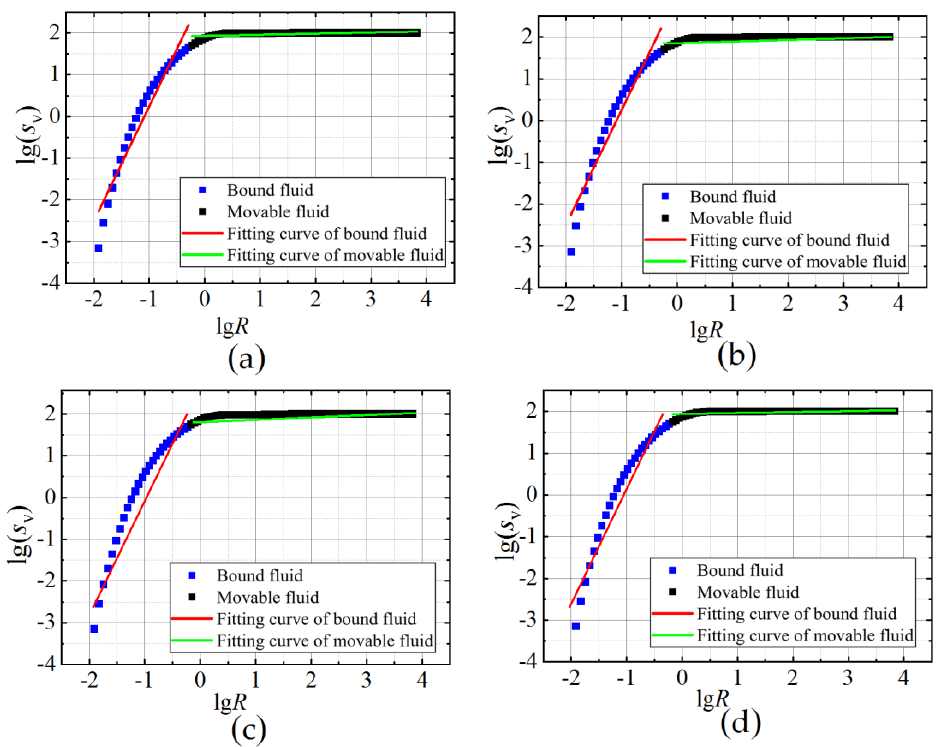
Figure 9. The lg S v-lg R curves under various freezing pressures: ( a – d ) represent 50 kPa, 100 kPa, 200 kPa and 400 kPa, respectively.